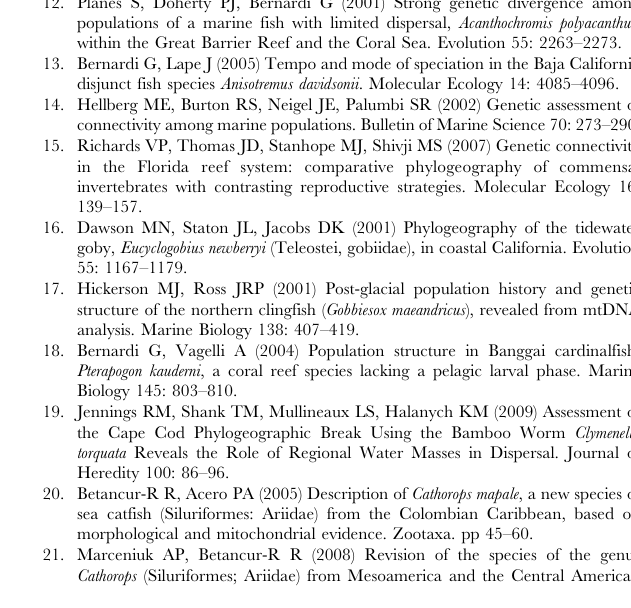
Table S1 Molecular material examined and GenBank accession numbers for the Cathorops mapale group. Locality codes follow Fig. 1; two letter country codes follow ISO-3166. See Betancur-R. (2009) for details on outgroup (non- Cathorops mapale group) material.